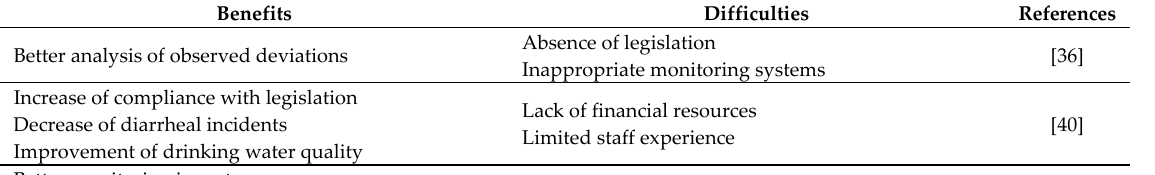
Table 2. The main benefits and difficulties of WSPs implementation in European water